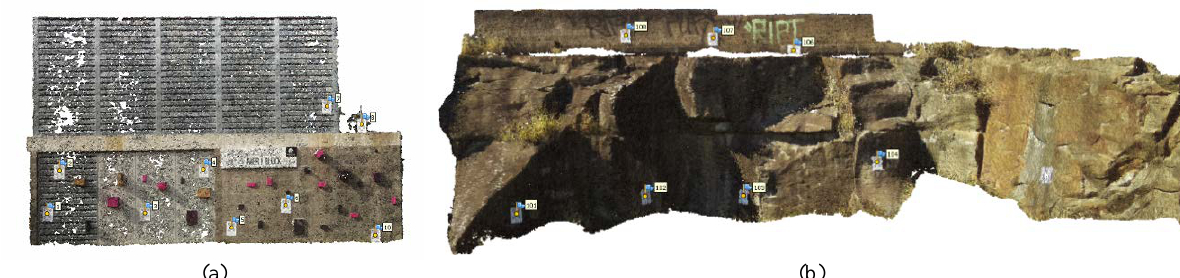
Figure 2. (a) 3D model of test site T1 with the building covered by targets and boxes of different sizes. (b) 3D model of the rock face of test site T2 with